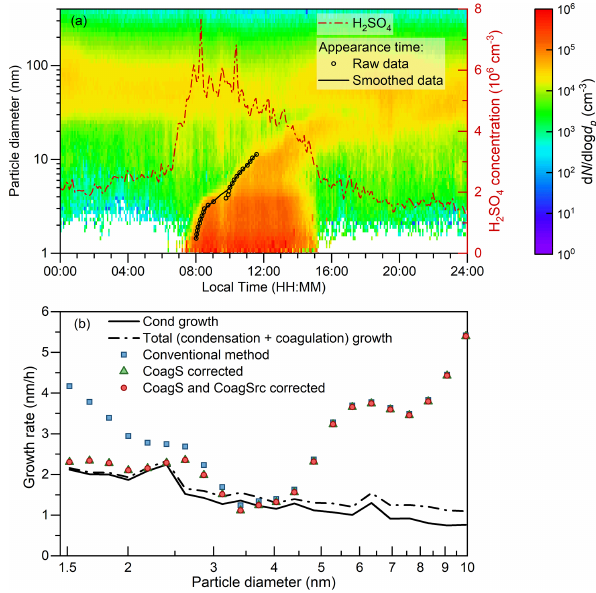
Figure 8. A case study for the appearance time method in the real atmosphere. (a) Aerosol size distribution and H 2 SO 4 concentration measured on an NPF day. The event was measured on 24 Febru- ary 2018, in urban Beijing. (b) Measured growth rates using the conventional and corrected appearance time methods and the the- oretical growth rate contributed by sulfuric acid condensation and particle coagulation. Note that the theoretical growth rate considers only the sulfuric acid condensation; hence, it may underestimate the overall condensation growth rate contributed by multiple condens- ing